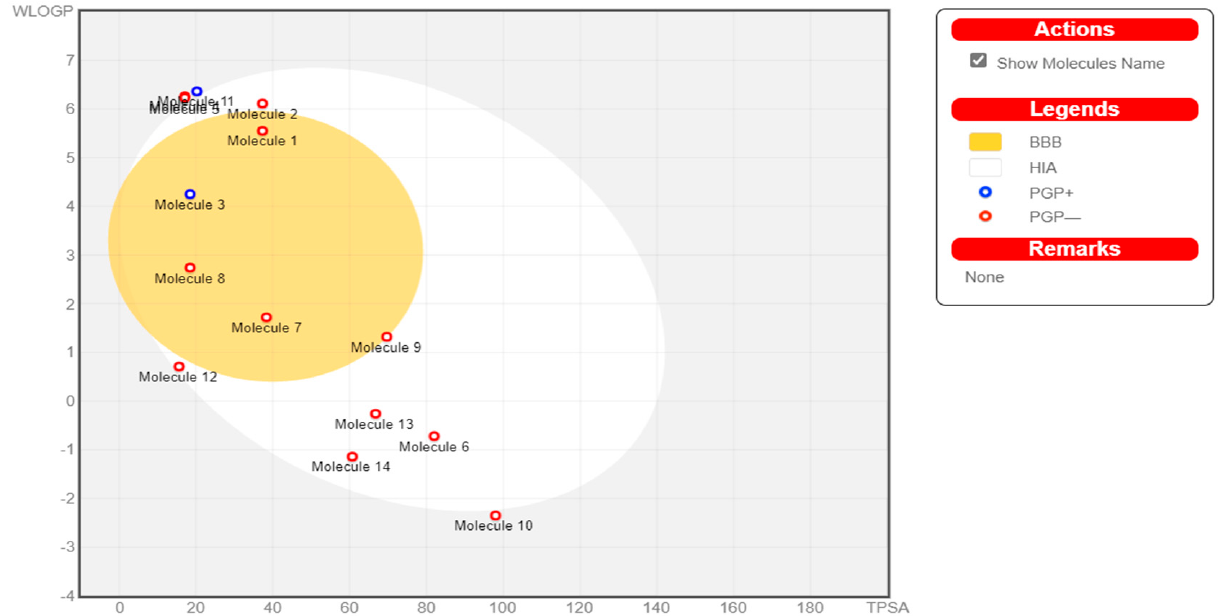
Figure 3. Boiled-Egg assessment: Molecule 1—hexadecanoic acid; Molecule 2—cis-vaccenic acid;